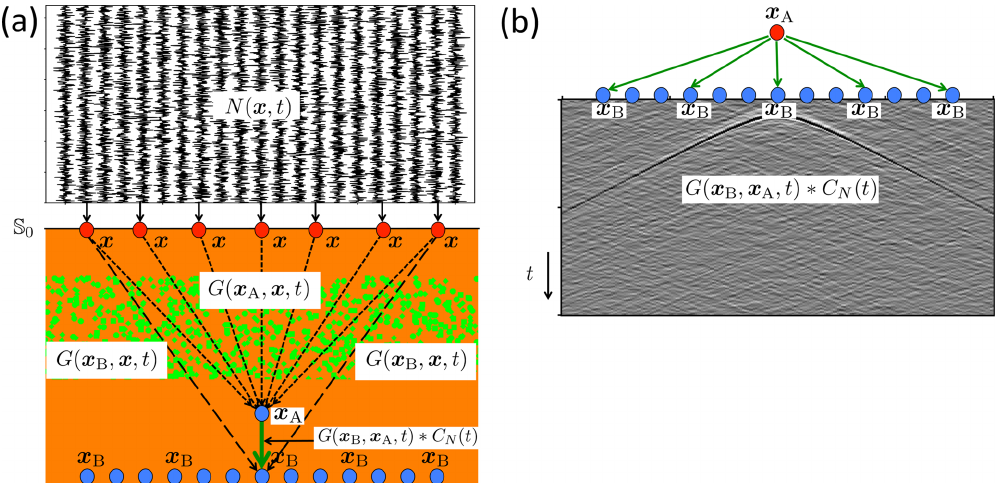
Figure 4. Principle of seismic interferometry. (a) Propagation of ambient noise from S 0 through an inhomogeneous medium to receivers at x A and x B . (b) Cross-correlation of responses at x A and x B (with x A fixed and x B